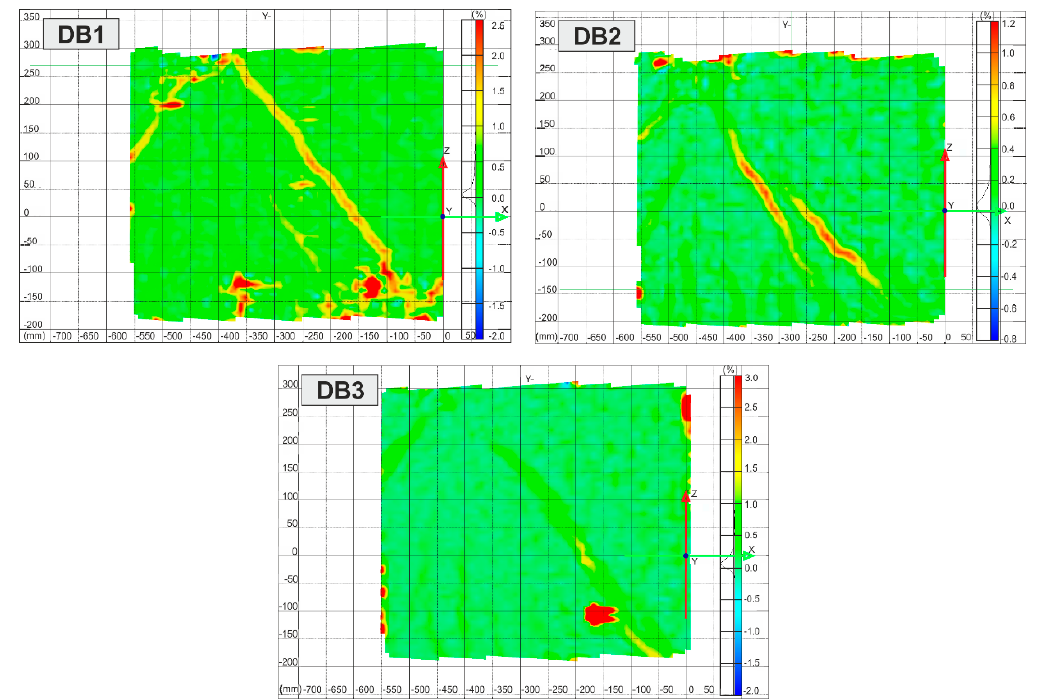
Figure 10. Contours of principal strains at load of 520 kN.